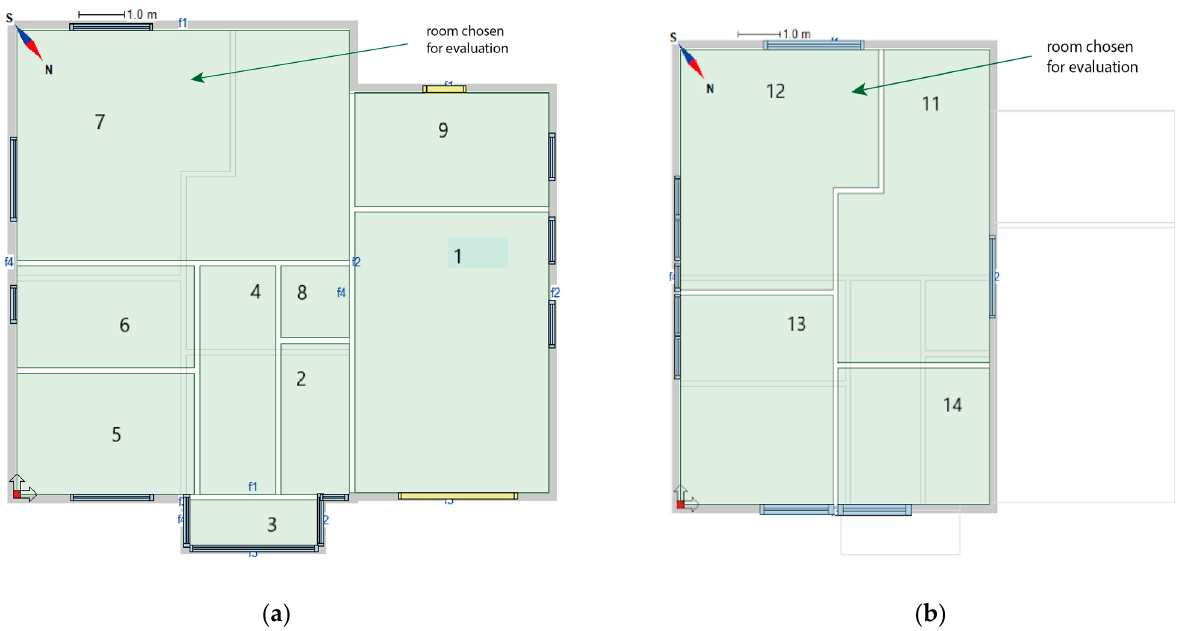
Figure 2. ( a ) First floor of single-family residential house building; ( b ) second floor of